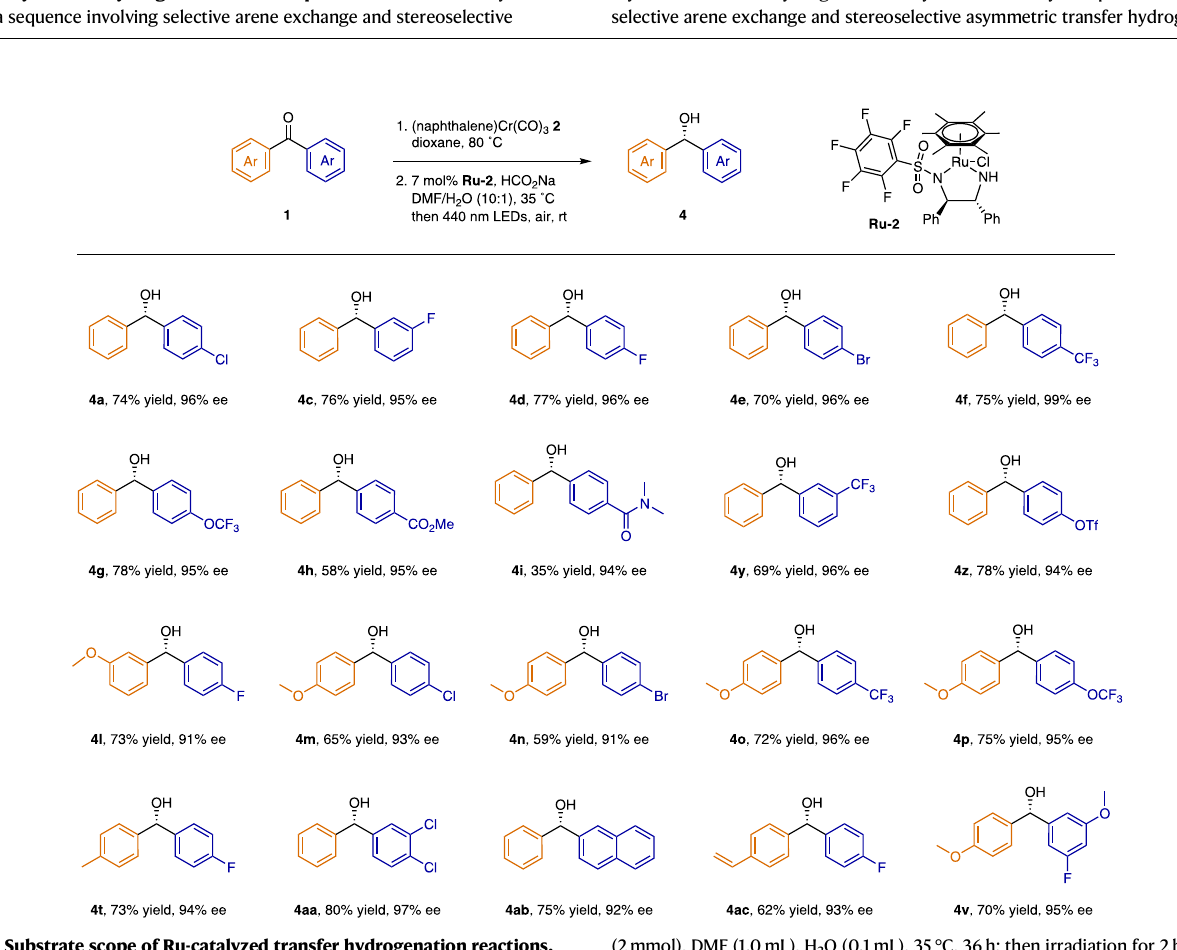
Fig. 6 | Substrate scope of Ru-catalyzed transfer hydrogenation reactions. Synthesisof compoundsbearing achiral gem -diarylmotiffrombenzophenonesby a sequence involving selective arene exchange and stereoselective asymmetric transfer hydrogenation. Reaction conditions, unless otherwise noted: (1) 1 (0.2mmol), 2 (0.3mmol),dioxane(2.0mL),80°C,24h.(2) Ru-2 (7mol%),NaCO 2 H